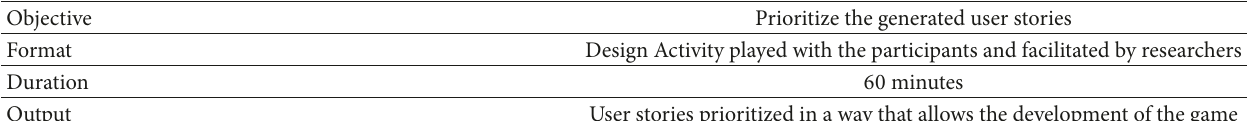
Table 6: Summary of the characteristics of Session 4.